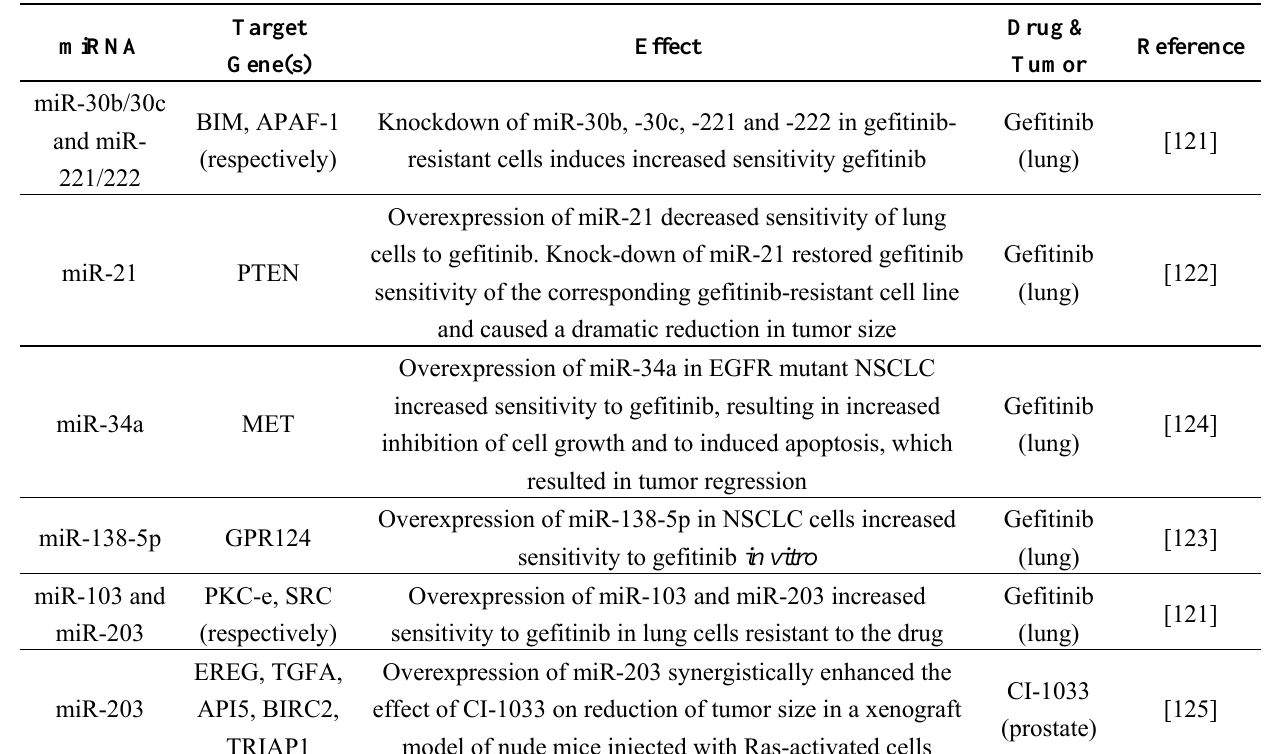
Table 2. miRNAs modulating efficacy of